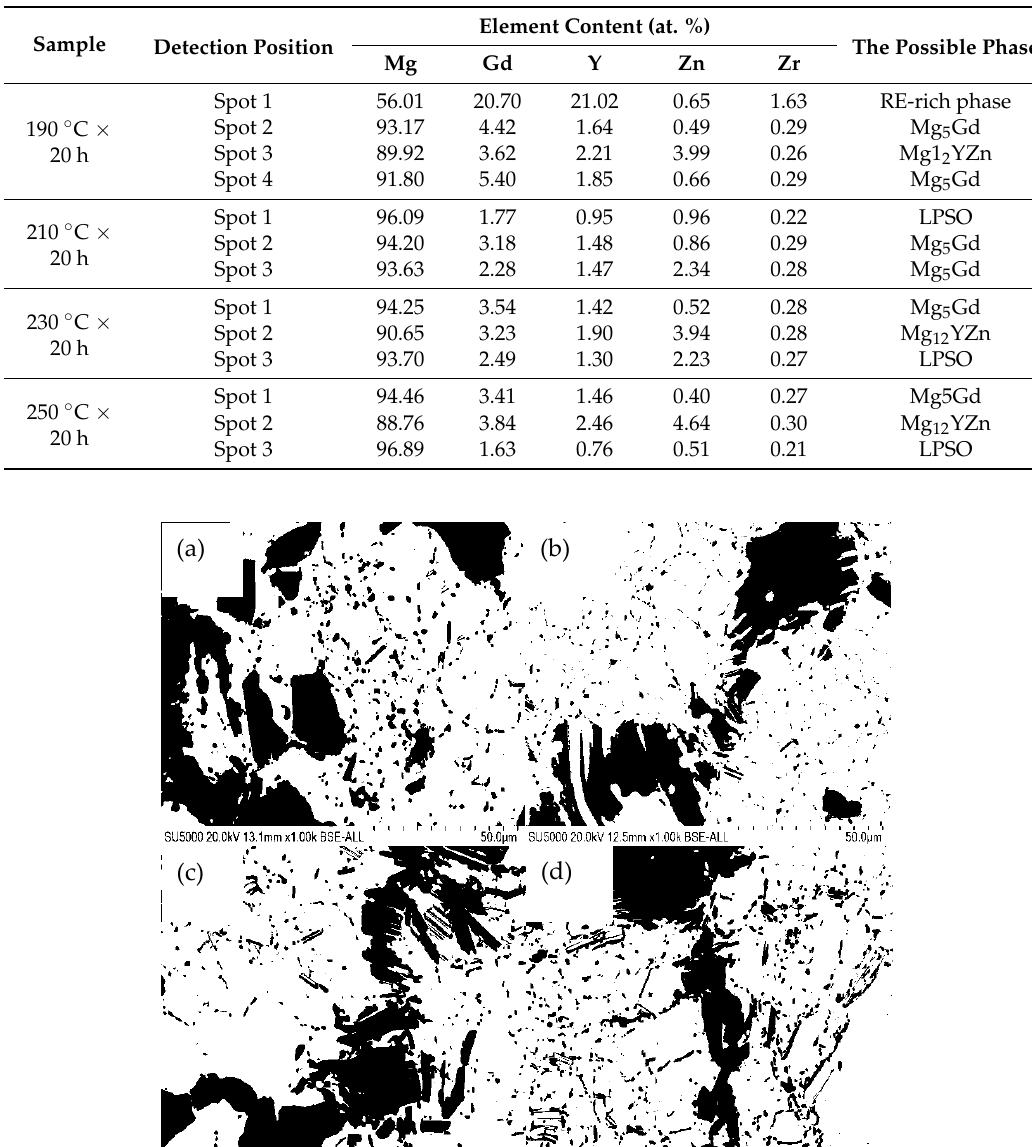
Table 2. EDS results for the precipitated phases shown in Figure 8.